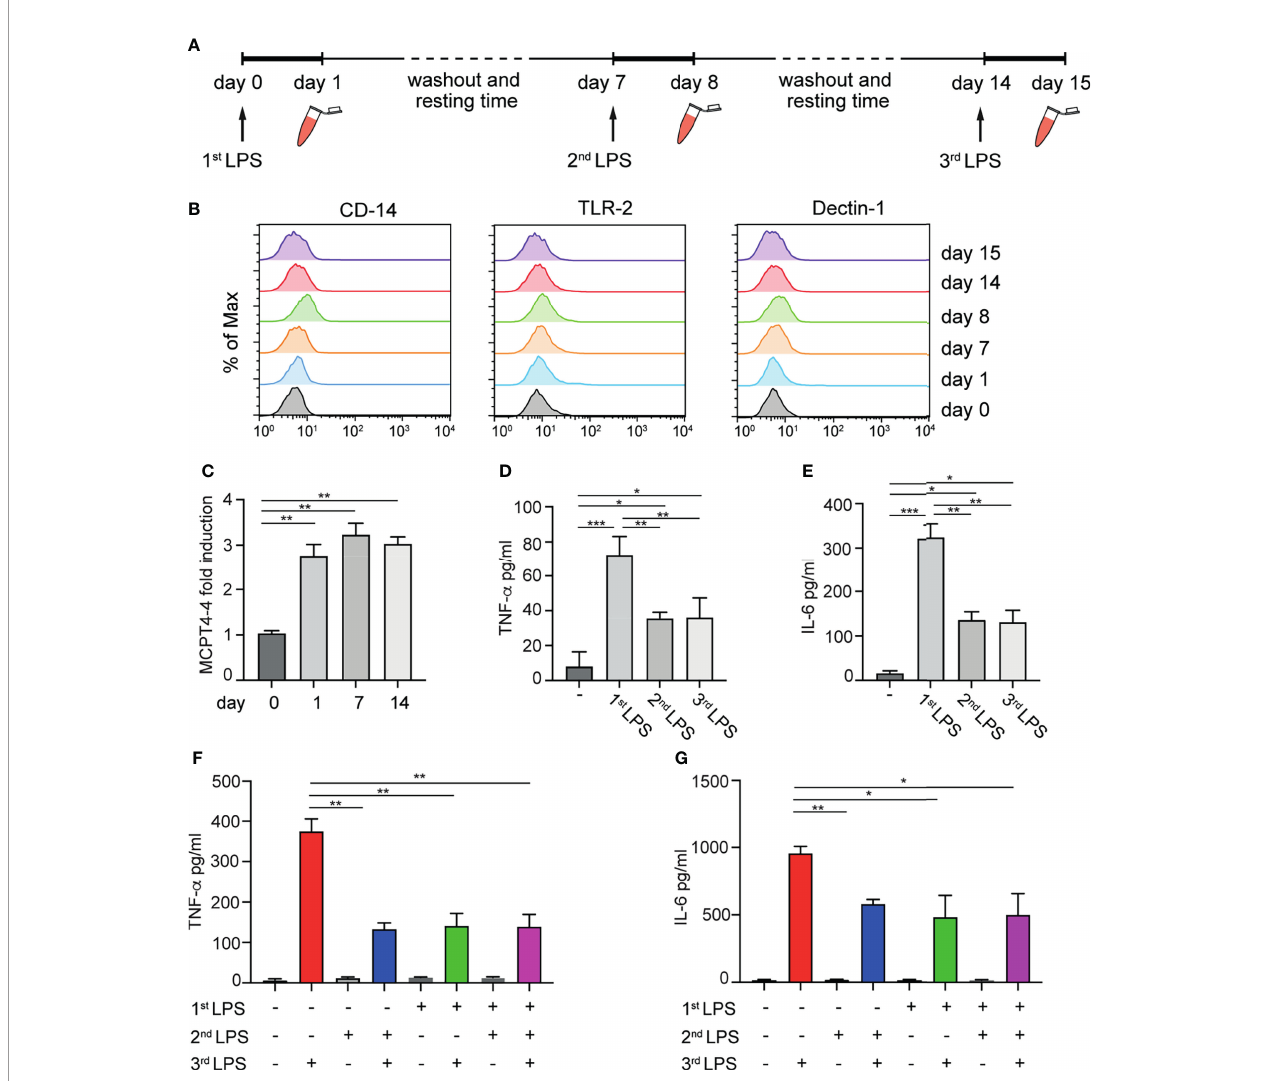
FIGURE 6 | Effect of repetitive LPS stimulation on BMMCs. Schematic representation of experimental protocol: 4-weeks old BMMCs were treated for 24h with LPS once a week for three weeks (A) . Surface marker expression (B) and MCPT-4 mRNA expression (C) were evaluated at indicated times. The levels of TNF- a (D) and IL-6 (E) released by BMMC after the fi rst, the second and the third dose of LPS are shown. The levels of TNF- a (F) and IL-6 (G) released by BMMC treated with one or more doses of LPS have been compared. Data are means +SD. Statistical analysis were performed with one-way Anova with Dunnet correction (*p < 0,05 **p < 0,01; ***p <